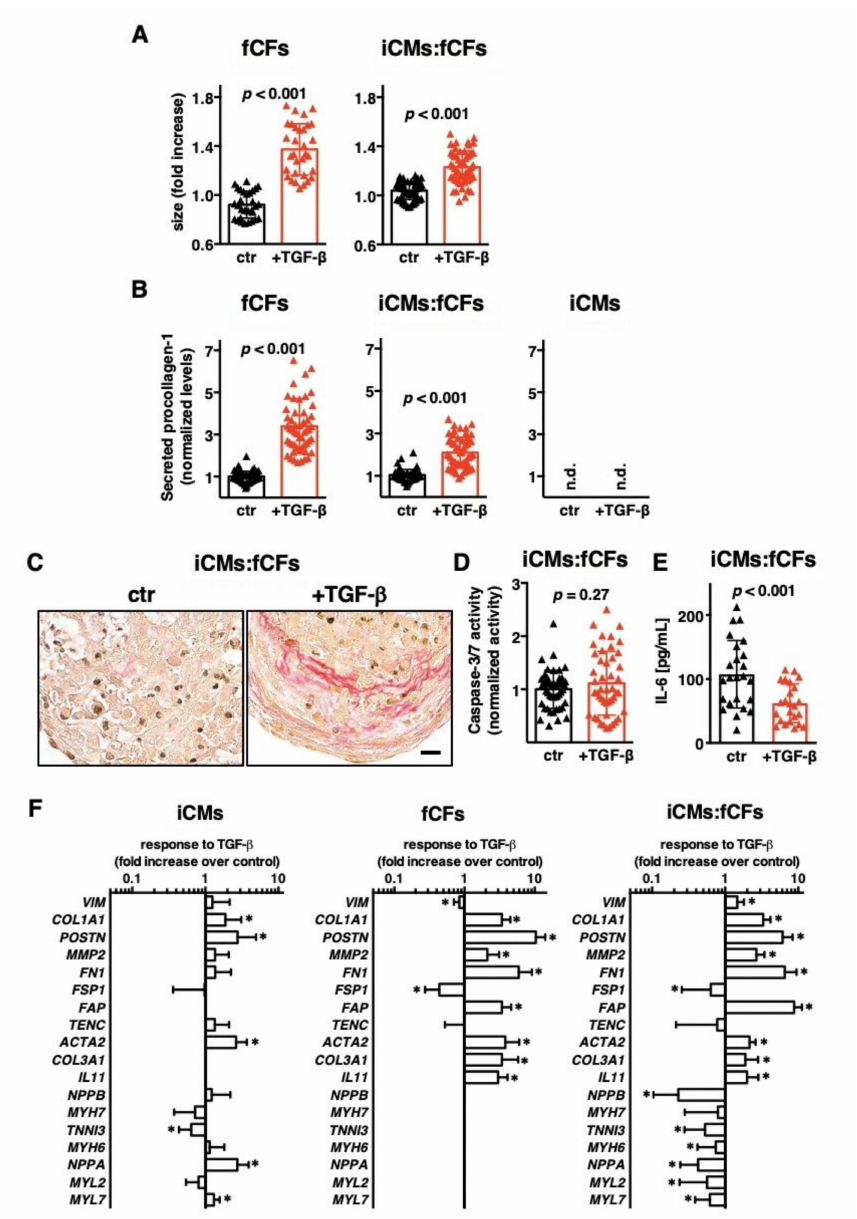
Figure 2. TGF- β 1 activates foetal cardiac fibroblasts in microtissues. Panel ( A ) demonstrates changes in size of microtissues generated with fCFs only (fCFs, left) and iCMs mixed with fCFs in ratio 4:1 (iCMs:fCFs, right) cultured in the presence (red) or absence (black) of TGF- β 1 (10 ng / mL) for 10 days. Panel ( B ) shows relative levels of procollagen I (measured by ELISA), at day 10 in supernatants of all three microtissue types: fCFs (left), iCMs:fCFs (middle) and iCMs (right). Graphs show cumulative data of 2–5 independent experiments. Each dot represents data of one microtissue. Panel ( C ) illustrates representative picrosirius red staining in iCMs:fCFs microtissues at day 10 (bar = 10 µ m). Panel ( D ) shows caspase 3 / 7 activity measured at day 10 in iCMs:fCFs microtissues. Graphs show cumulative data of 3 independent experiments. Panel ( E ) shows IL-6 levels measured by ELISA, at day 10 in supernatants of iCMs:fCFs microtissues. Graphs show cumulative data of 3 independent experiments. Each triangle represents data of one microtissue. Panel ( F ) summarizes fold changes in gene expression in indicated microtissues in the presence of TGF- β 1 (in relation to expression in the absence of TGF- β 1). * p < 0.05. Graphs show cumulative data of 3–4 independent experiments, n = 11–20. For all graphs, p values were calculated with the Student’s t -test. n.d.—not